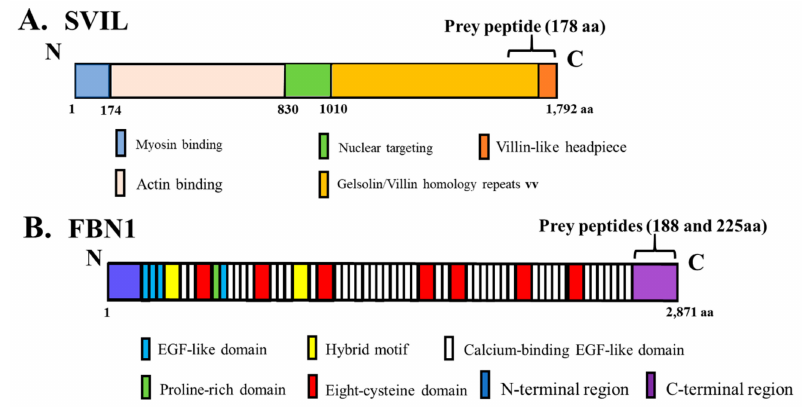
Figure 4. ( A ) Diagram of the domain structure of the full-length SVIL protein. The domains are color-coded, and the location of the 178 aa prey peptide (aa 1615–1792) is indicated by a bracket. The amino acid numbers are indicated below the diagram. ( B ) Diagram of the domain structure of the full-length FBN1 protein. The domains are color-coded, and the location of the two overlapping prey peptides, 188 aa (aa 2684–2871) and 225 aa (aa 2647–2871), are indicated by a bracket. EGF: epidermal growth